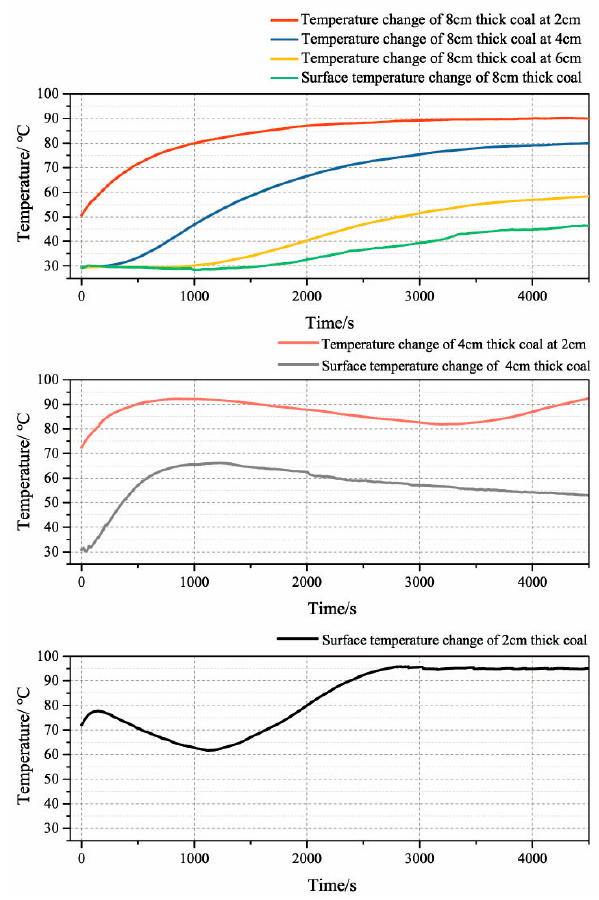
Figure 4. Temperature change of di ff erent thickness coal in thin-layer drying experiment.